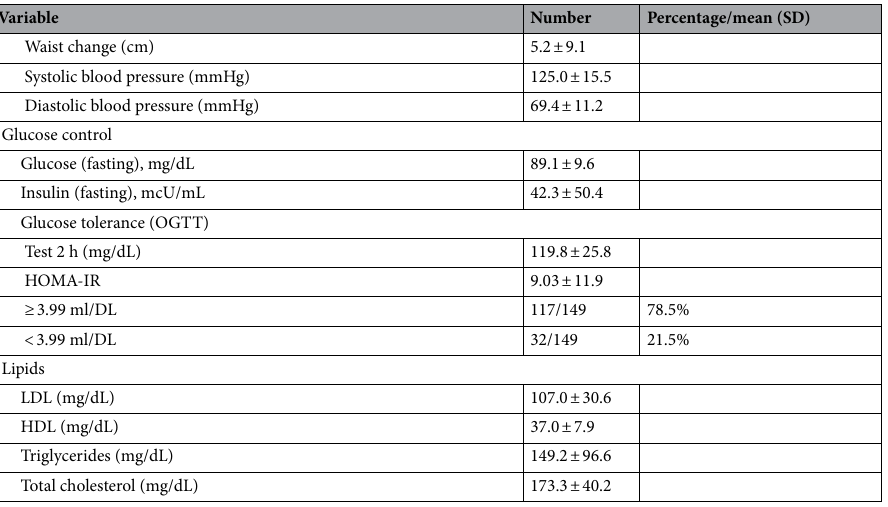
Table 1. TONIC patients with leukocyte telomere length data (n =